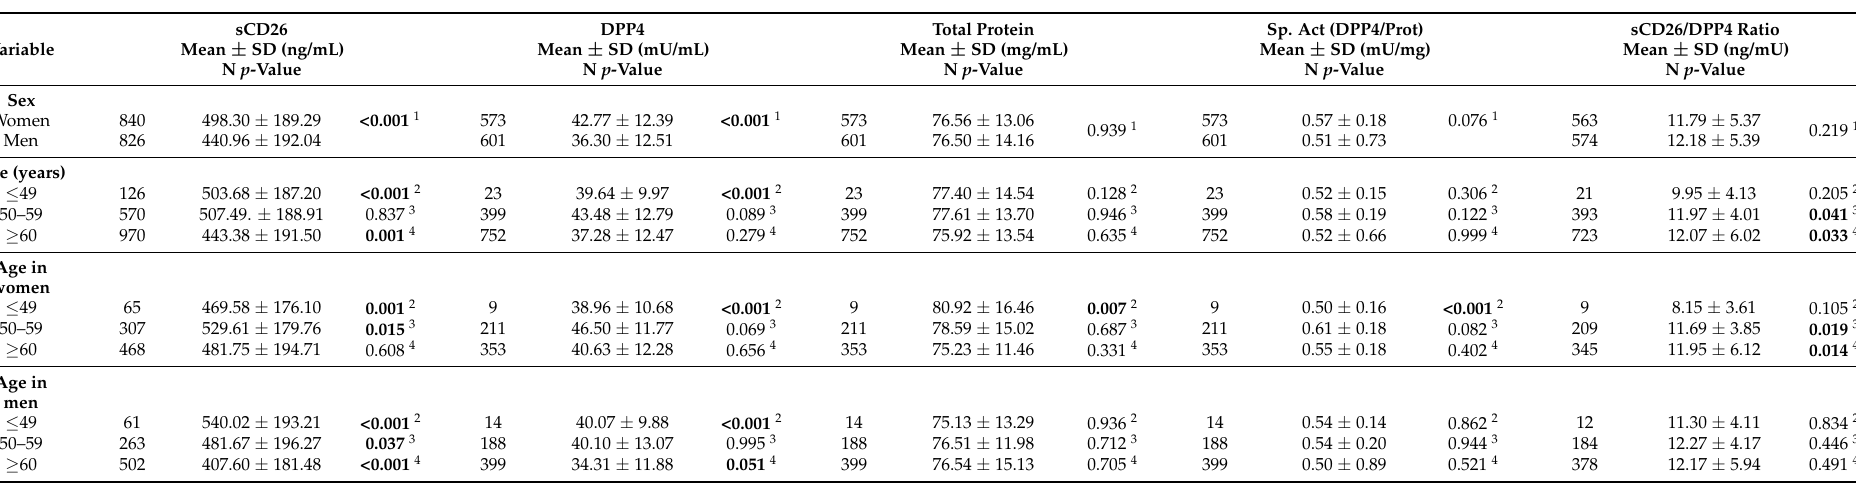
Table 2. Showing sCD26 and the other measurements regarding sex and age. Statistically significant differences (Student’s t -test, p -value < 0.001) between sex were found for sCD26 and DPP4 activity, both higher in women, but no differences were detected for the other parameters.